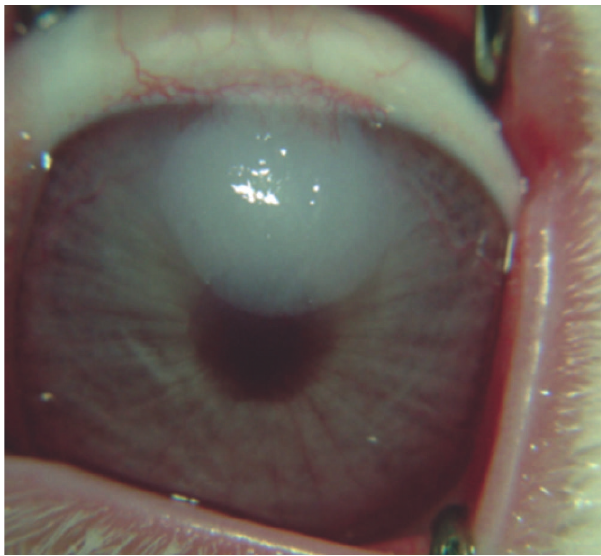
Figure 2 - Animal 5 from the study group showing the vessel extent reaching up to 75% of the burned area and minimal inflammatory reaction